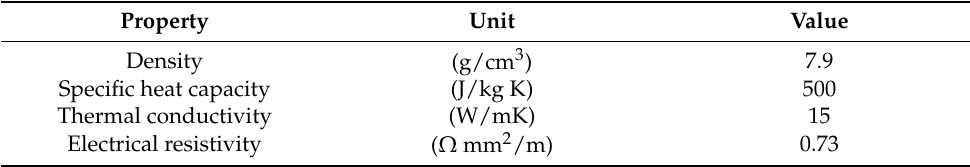
Table 2. Physical properties of 1.4541 (20 ◦ C)